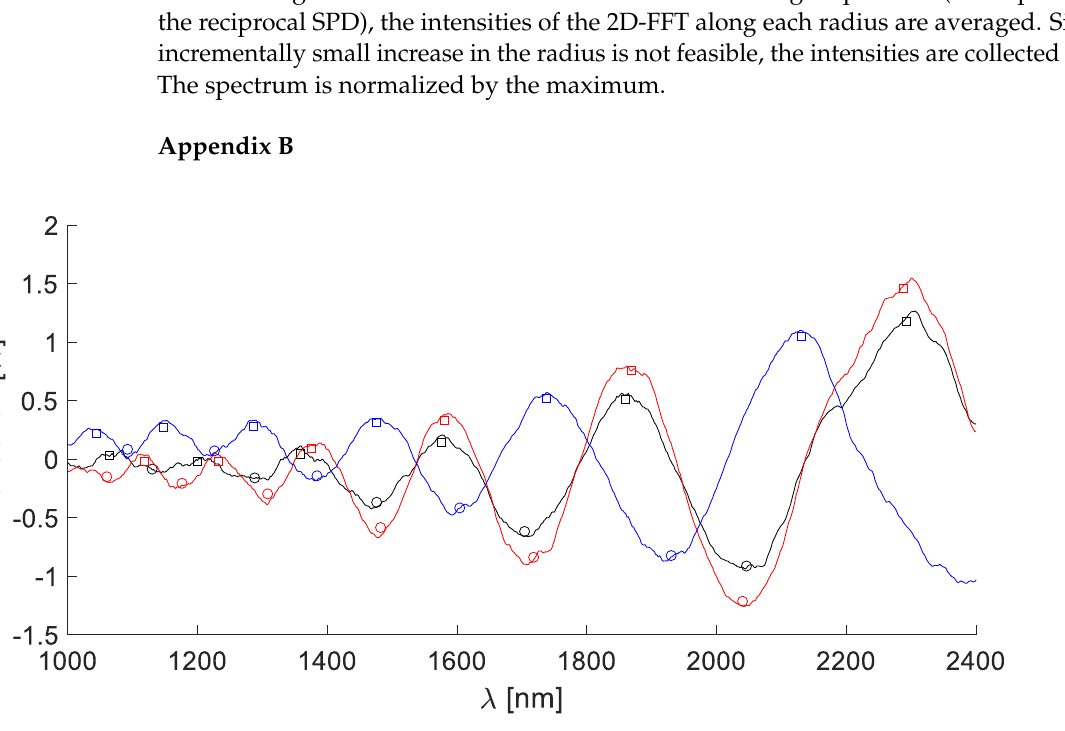
Figure A1. Normalized reflection changes in three DLC films on NBR H-AT-68-00. Minima (circles) and maxima (squares) are highlighted. The respective film thicknesses and refractive indices are: 2.54 µm and 1.97 (black), 2.77 µm and 1.99 (red), 2.58 µm and 1.97 (blue).